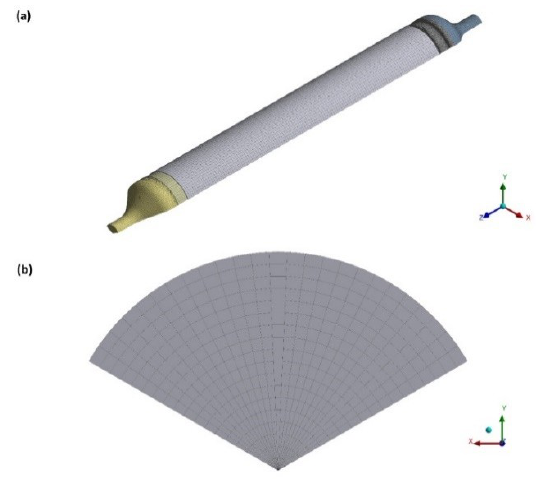
Figure 2. The computational grid used for the computer simulations. View along the side of the system showing the overall arrangement ( a ), and a cross-sectional view of the grid distribution in a sector ( b ).